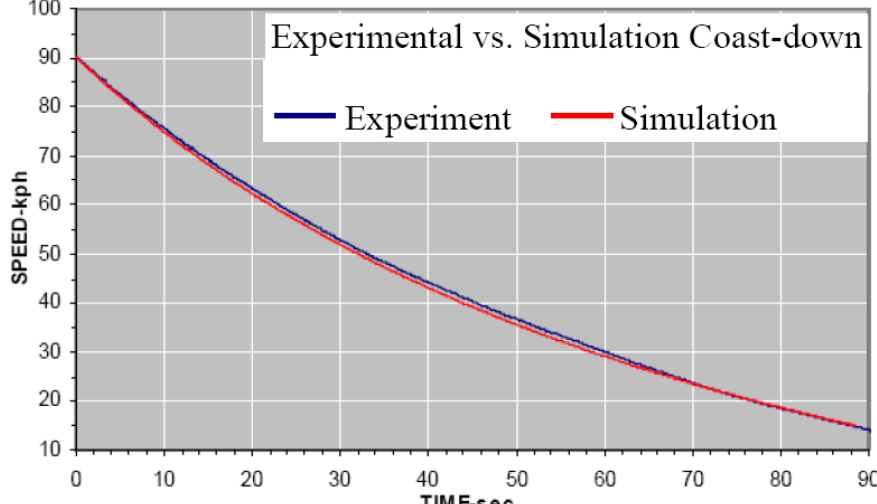
Figure 5. Coast-down